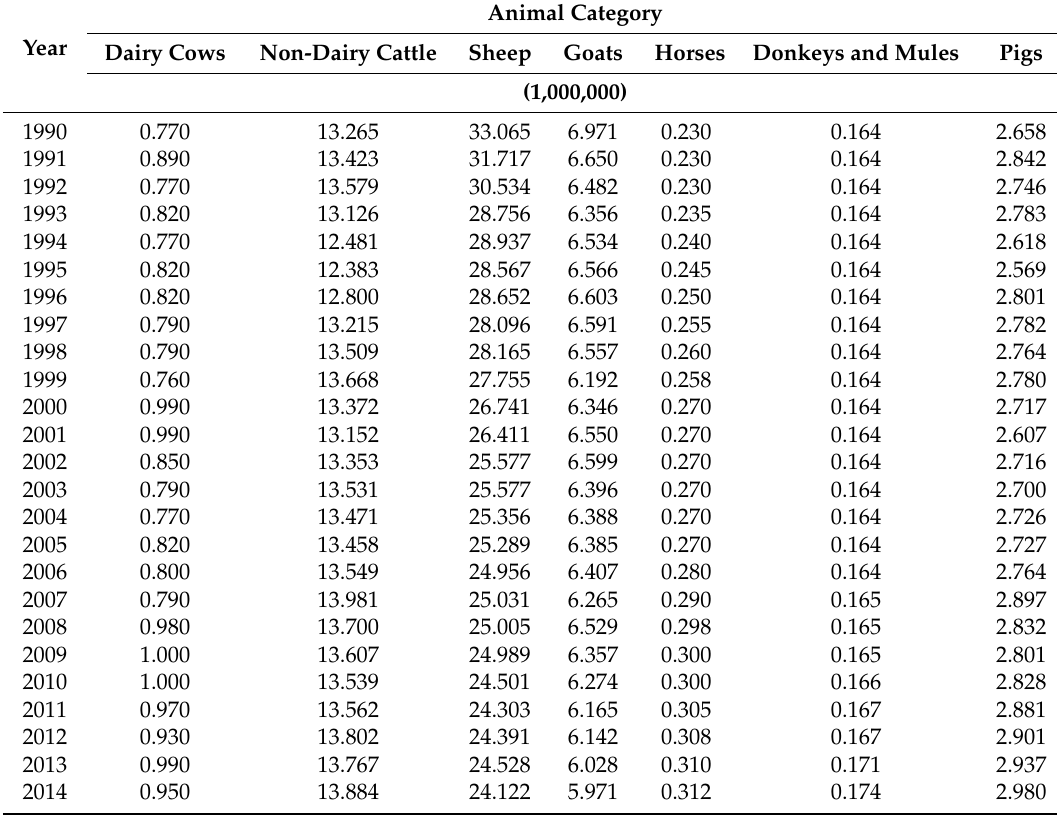
Table 1. Annual animal population data from 1990 to 2014 in South Africa. Animal Category Year Dairy Cows Non-Dairy Cattle Sheep Goats Horses Donkeys and Mules Pigs